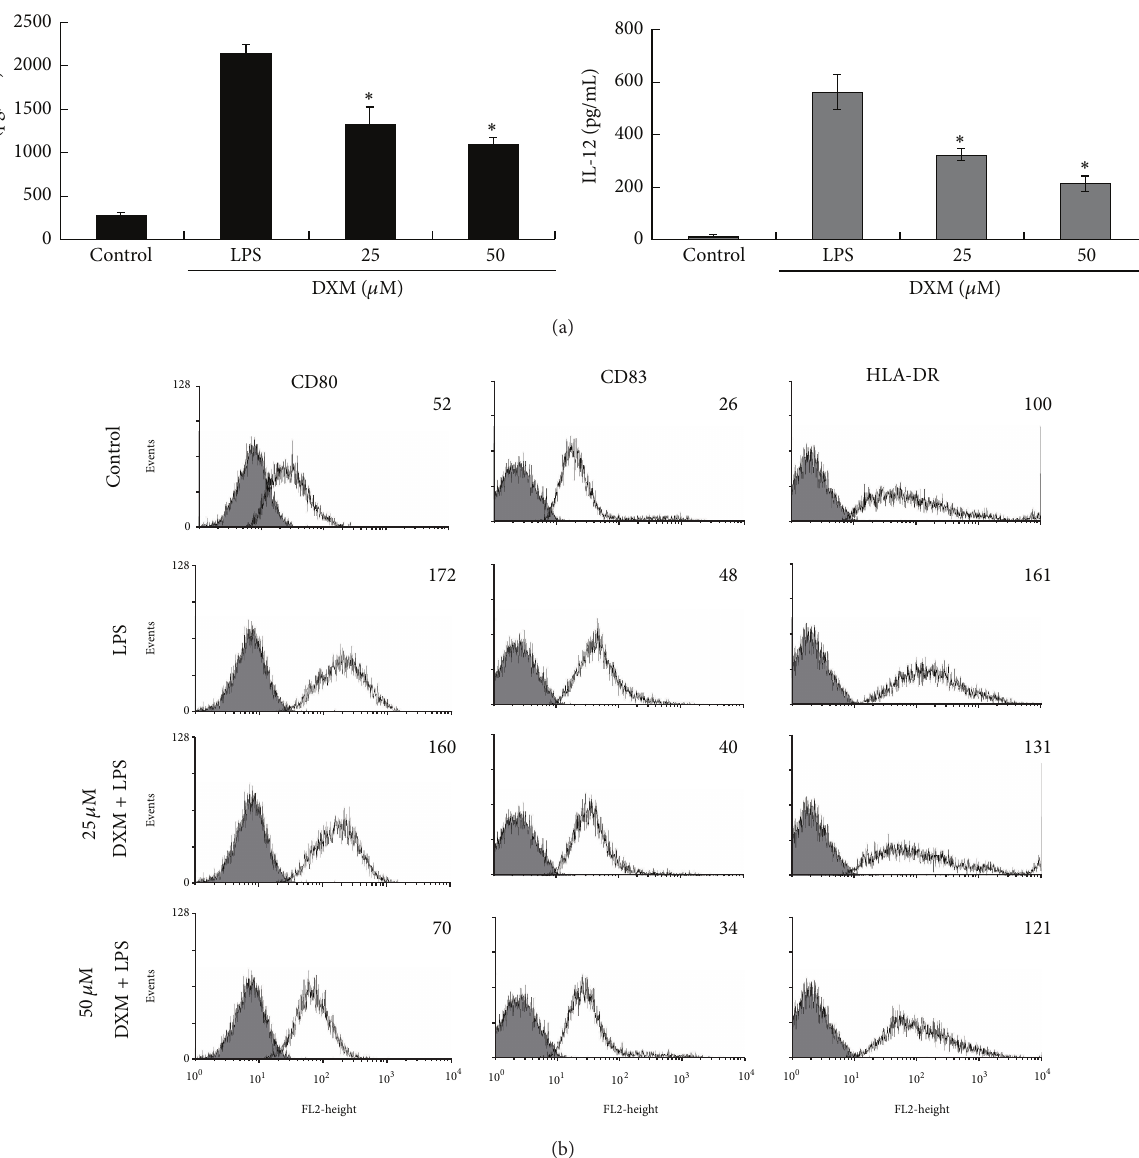
Figure 6: DXM inhibited human MDDC activation. Immature MDDCs were treated with LPS (100ng/mL) + IFN- 𝛾 (10ng/mL), LPS (100ng/mL) + IFN- 𝛾 (10ng/mL) + DXM (25, 50 𝜇 M) for 18h. The control group was treated with PBS alone. (a) Supernatants were collected 18hlater(TNF,6 h),andTNF-alpha,IL-6,andIL-12productionwasmeasuredbyELISA.Dataarepresentedasthemean ± SDofsamplesfrom three wells. Significant differences between DXM-treated and untreated LPS + IFN- 𝛾 -activated DCs are shown with asterisks ( ∗ 𝑃 < 0.05 ). (b) The expression of CD80, CD83, and HLA was determined by flow cytometry. All data were gated on CD1a + cells. The gray-filled area represents staining with an isotype-matched control Ab. The change of geometric mean fluorescence intensity in the LPS + IFN- 𝛾 or LPS + IFN- 𝛾 + DXM samples is indicated. All data are representative of five independent experiments with cells from individual